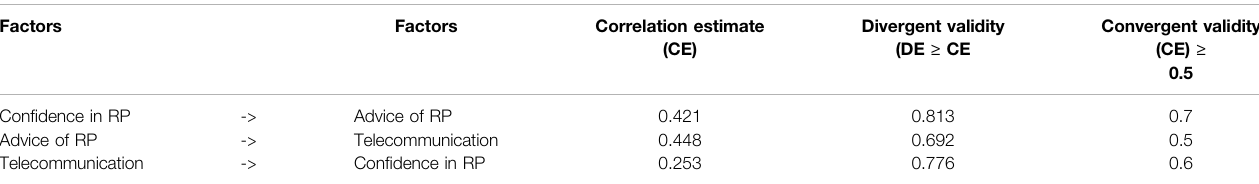
TABLE 8 | Convergent and Divergent Validity of